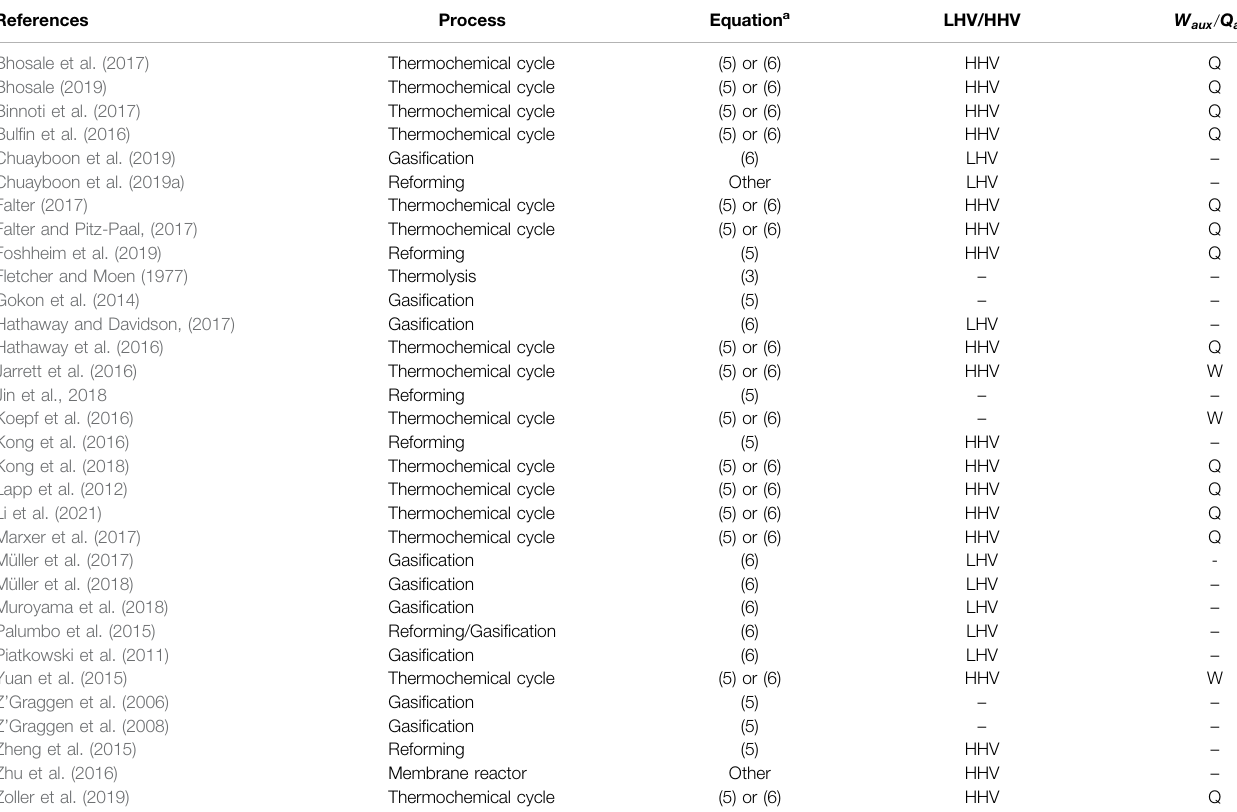
TABLE 1 | Ef fi ciency de fi nitions in the literature, with the process type, the type of ef fi ciency equation used, whether they use LHV or HHV, and if they include auxiliary work directly or convert it to